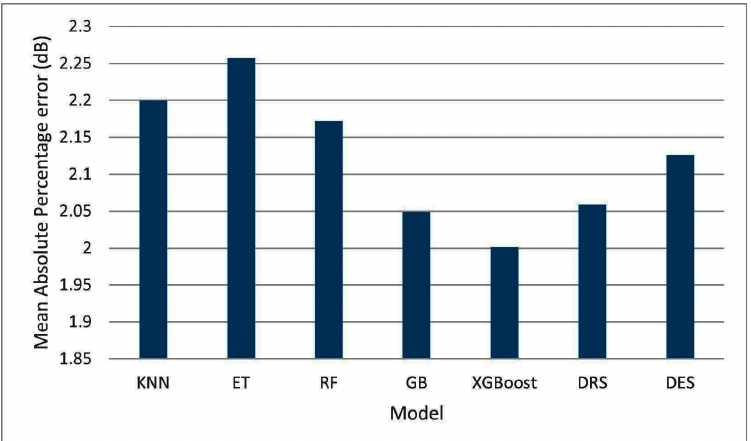
Figure 12. Mean Absolute Percentage Error of models based on dataset